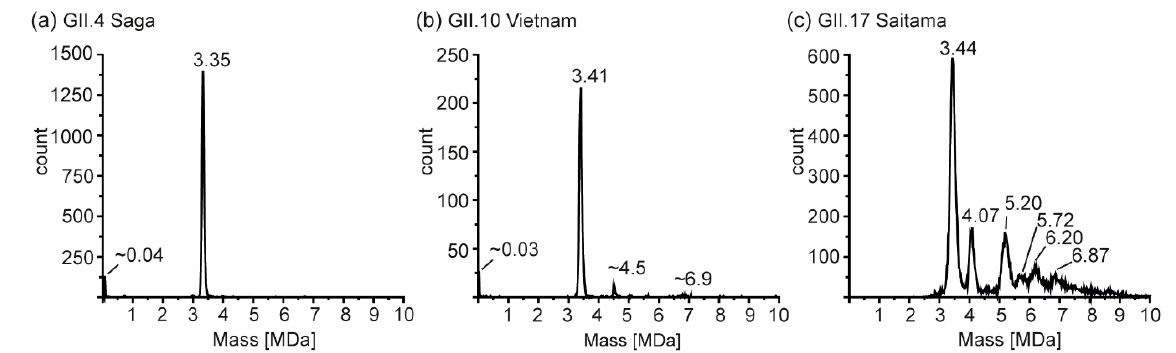
Figure 6. Charge detection mass spectrometry of hNoVLPs at 250 mM ammonium acetate pH 7 and 10 µM VP1. Illustrative spectra shown for ( a ) GII.4 Saga ( b ) GII.10 Vietnam, and ( c ) GII.17 Saitama. Distinct peaks are annotated; for GII.4 Saga and GII.10 Vietnam low-count species, masses are approximations.